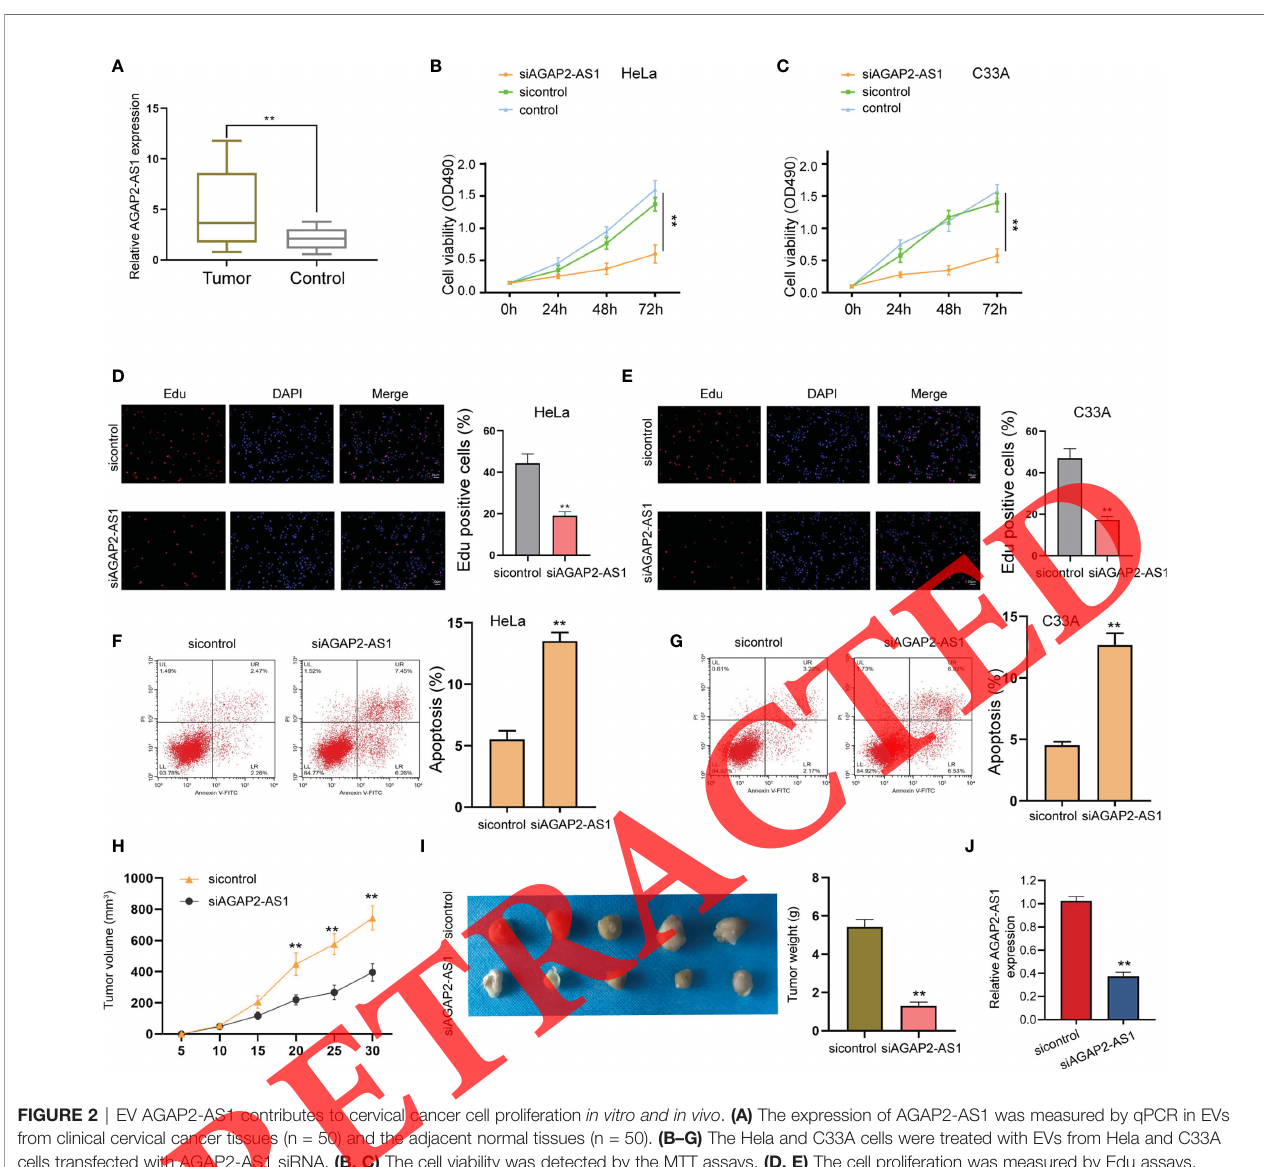
FIGURE 2 | EV AGAP2-AS1 contributes to cervical cancer cell proliferation in vitro and in vivo . (A) The expression of AGAP2-AS1 was measured by qPCR in EVs from clinical cervical cancer tissues (n = 50) and the adjacent normal tissues (n = 50). (B – G) The Hela and C33A cells were treated with EVs from Hela and C33A cells transfected with AGAP2-AS1 siRNA. (B, C) The cell viability was detected by the MTT assays. (D, E) The cell proliferation was measured by Edu assays. (F, G) The cell apoptosis was evaluated by fl ow cytometry analysis. (H, I) The tumorigenicity analysis was performed in the nude mice. The nude mice (n = 5) were injected with Hela cells and treated with EVs from Hela cells transfected with AGAP2-AS1 siRNA. The tumor growth curve (H) , tumor volume and tumor weight (I) were shown. (J) Relative levels of AGAP2-AS1 were detected in mice tumors by qPCR. mean ± SD, ** P <